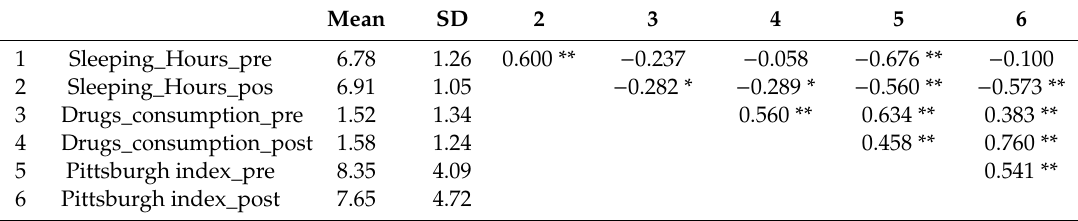
Table 3. Mean, standard deviation and correlations between the